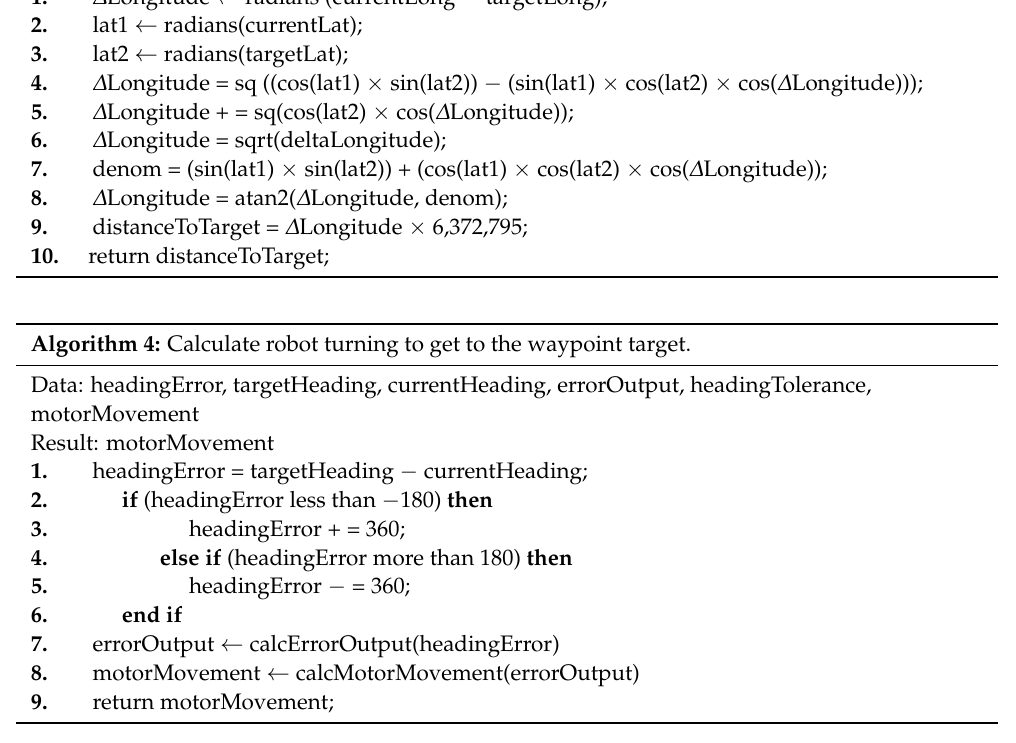
Algorithm 4 is a heading error computation when the target heading value differs